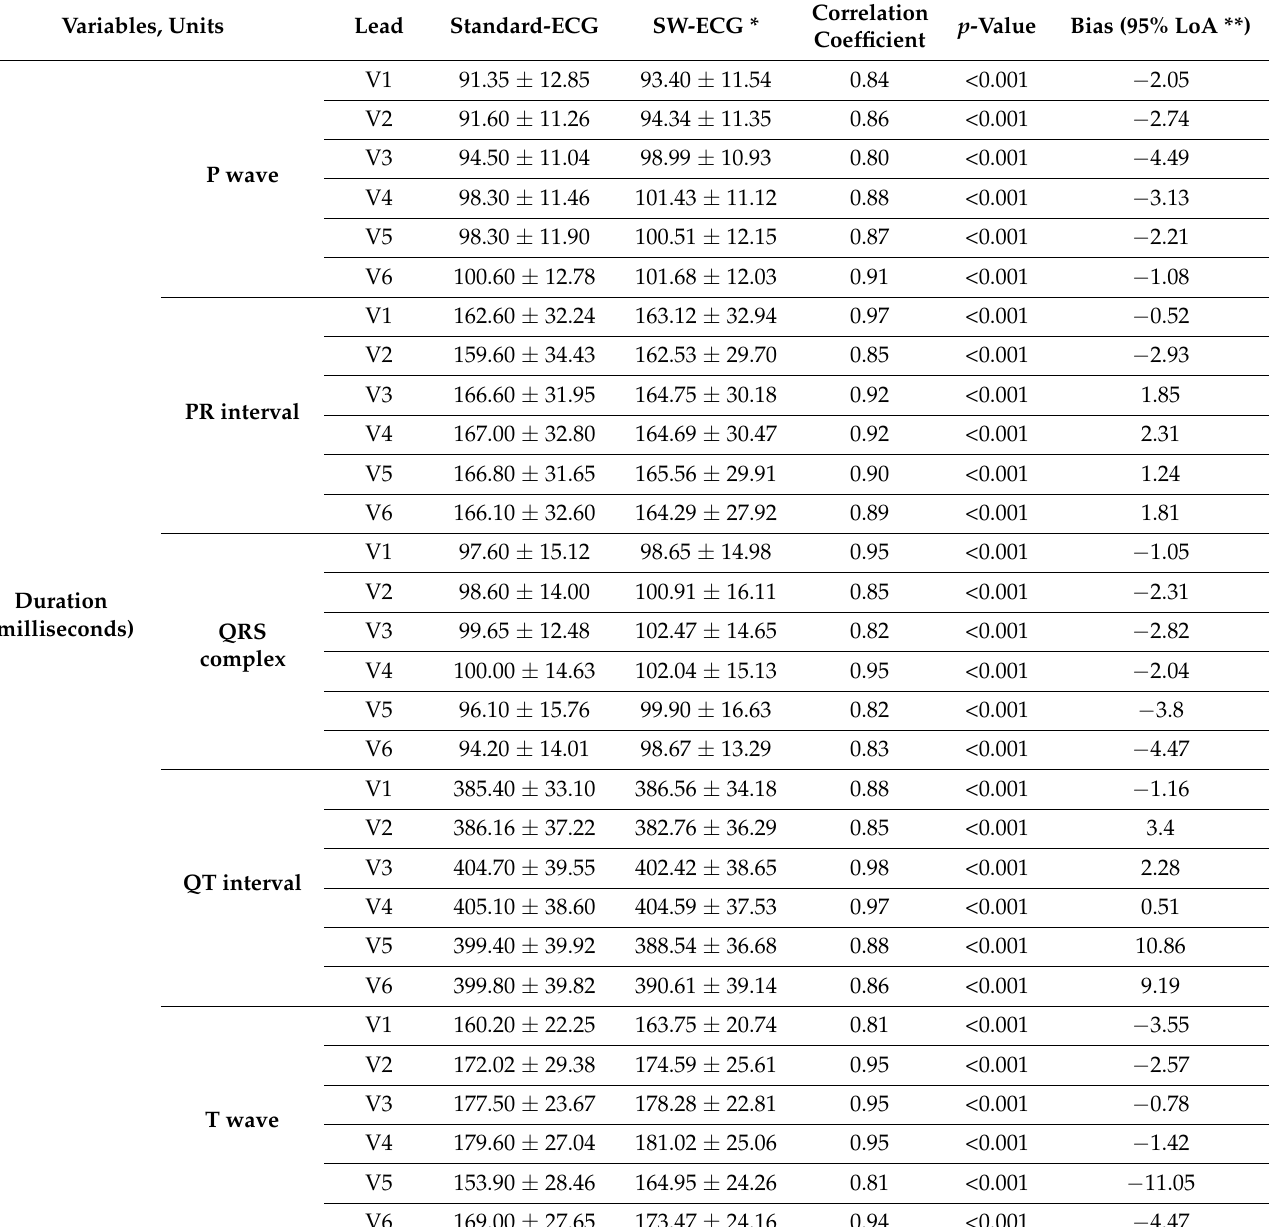
Table 3. ECG characteristics (duration, mean ±